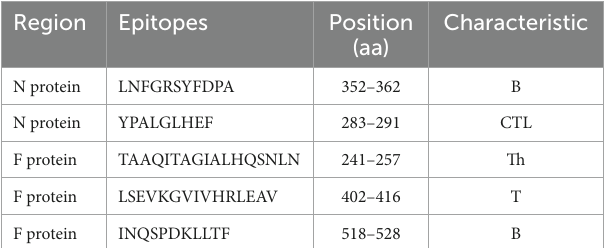
TABLE 2 CDV antigenic epitopes for chimera construction of CPV VP2